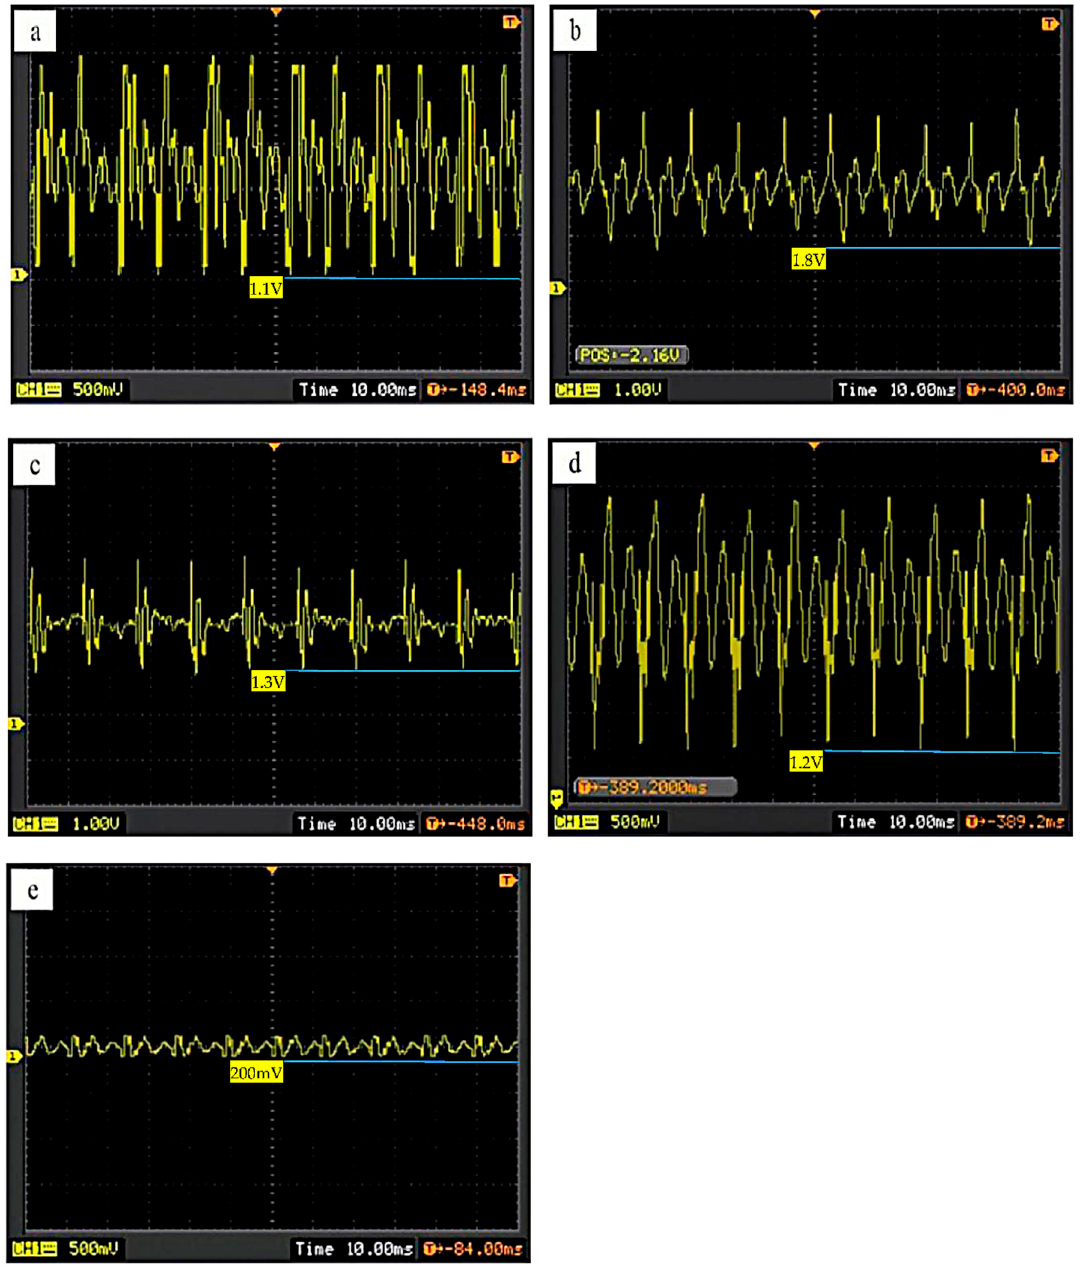
Figure 20. Piezoelectric signal of the fiber membrane at different addition of nanographene: ( a ) the addition of 0.5 wt%; ( b ) the addition of 1.0 wt%; ( c ) the addition of 1.5 wt%; ( d ) the addition of 2.0 wt%; ( e ) 1 wt% unmodified nanographene. Table 10. Piezoelectric signal of the fiber membrane at different loading of nanographene.